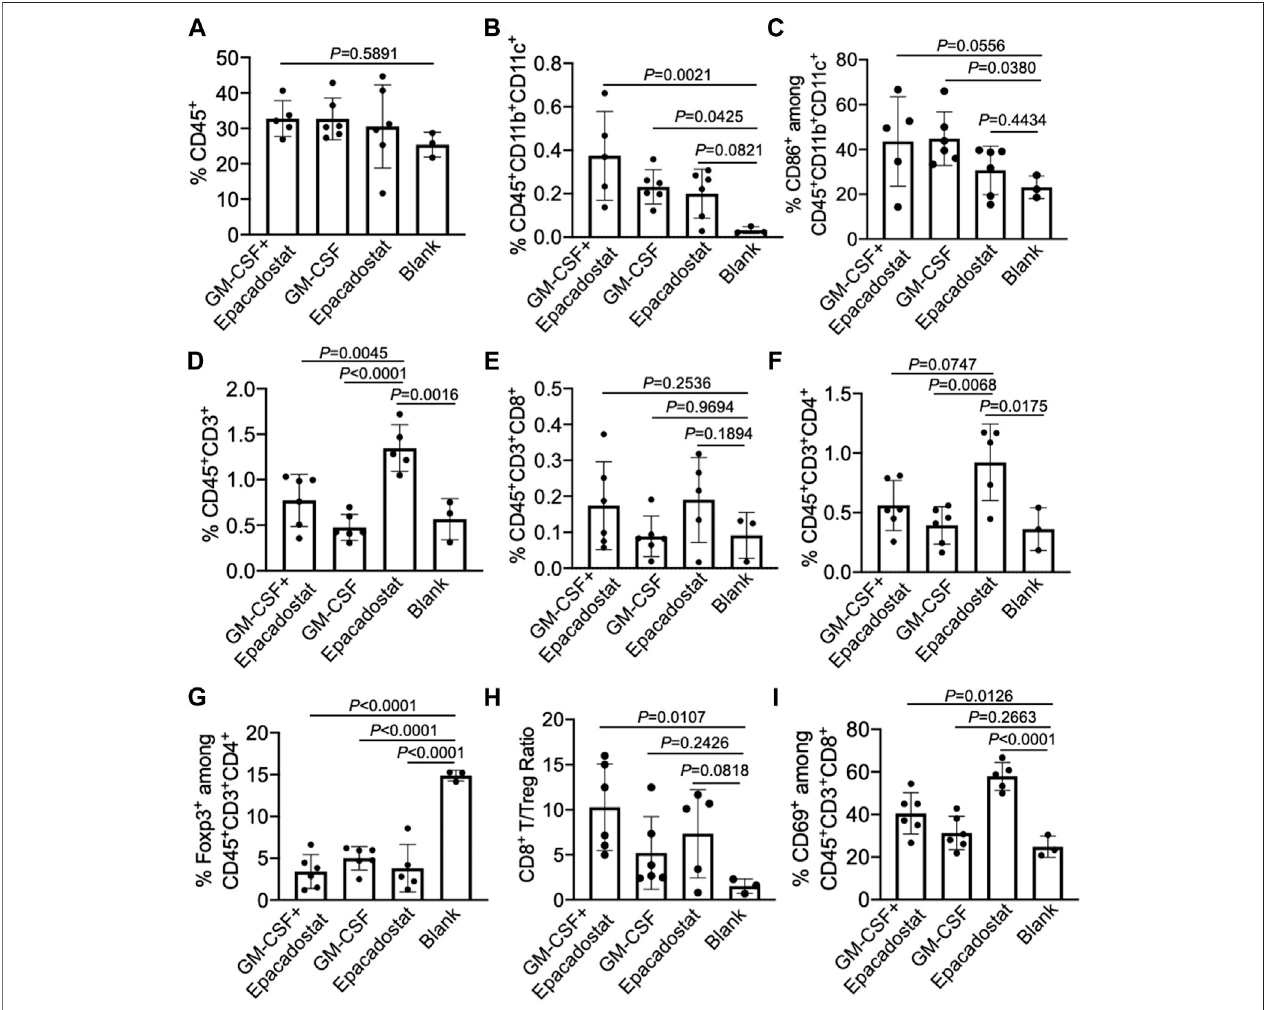
FIGURE6| Gels loadedwithGM-CSFandepacadostatcanreshape 4T1tumor microenvironment. 4T1tumors wereinoculated onday0,followedbyperitumoral injection of gel loaded with GM-CSF and epacadostat, gel loaded with GM-CSF alone, gel loaded with epacadostat, or blank gel on day 14. Gels and tumors were harvested for analysis on day 18. (A) Percentage of CD45 + cells in tumors. (B) Percentage of CD45 + CD11b + CD11c + DCs in tumors. (C) Percentage of CD86 + cells among CD45 + CD11b + CD11c + DCs in tumors. (D) Percentage of CD45 + CD3 + T cells in tumors. (E) Percentage ofCD8 + T cells in tumors. (F) Percentage of CD4 + T cells in tumors. (G) Percentage ofFoxP3 + Treg cells in tumors. (H) CD8 + T/Treg number ratiosin tumors. (I) Percentage ofCD69 + cells among CD8 + T cells in tumors. All the numerical data are presented as mean ± SD (0.01 < * p ≤ 0.05; ** p ≤ 0.01; *** p ≤ 0.001).